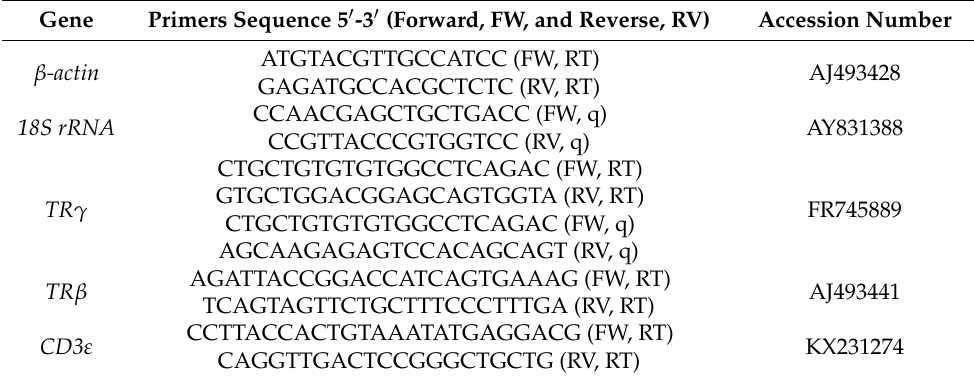
Table 1. Primer sequences used for RT- and q-PCR